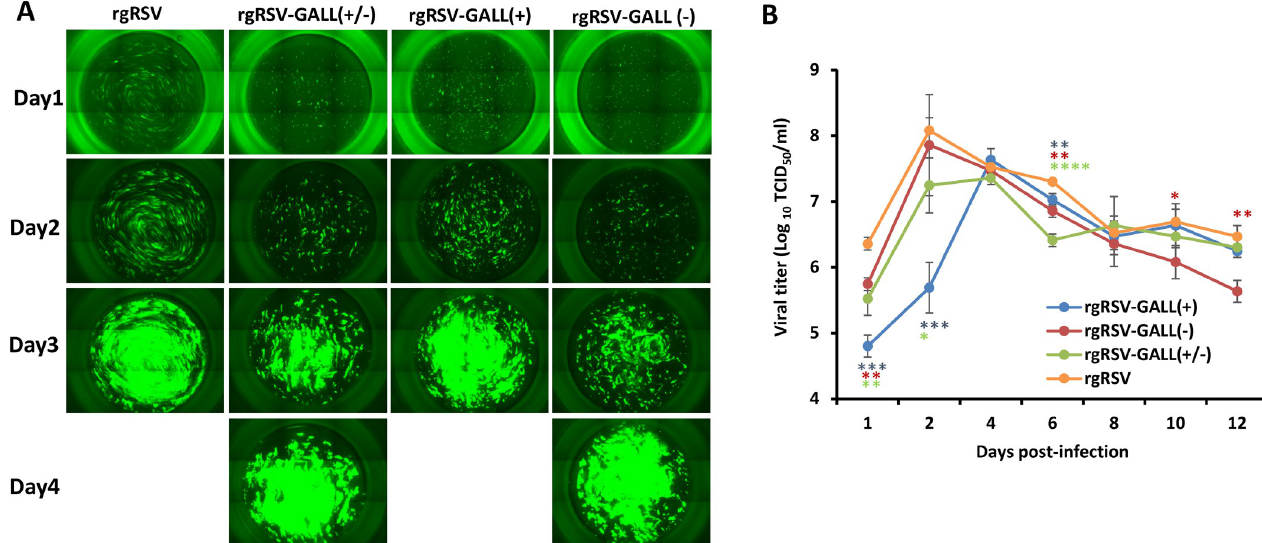
Fig 6. RSV replication in HBE cultures. (A) Spreading of m 6 A-deficient rgRSVs in HBE culture. HBE cultures were infected by 400 TCID 50 of each rgRSV mutant. At the indicated time, virus spread was monitored by fluorescence microscopy. Representative micrographs at each time point are shown. (B) Virus release from m 6 A-deficient rgRSV-infected HBE culture. HBE cultures were infected by 400 TCID 50 of each rgRSV. After virus inoculation, supernatants were collected on day 1 and every 2 days until day 12 post-inoculation. Infectious virus in supernatants was determined by TCID 50 assay. Viral titers are the geometric mean titer (GMT) of three independent experiments ± standard deviation. Data were analyzed using Student’s t -test and � P < 0.05; �� P < 0.01; ��� P < 0.001; ���� P <